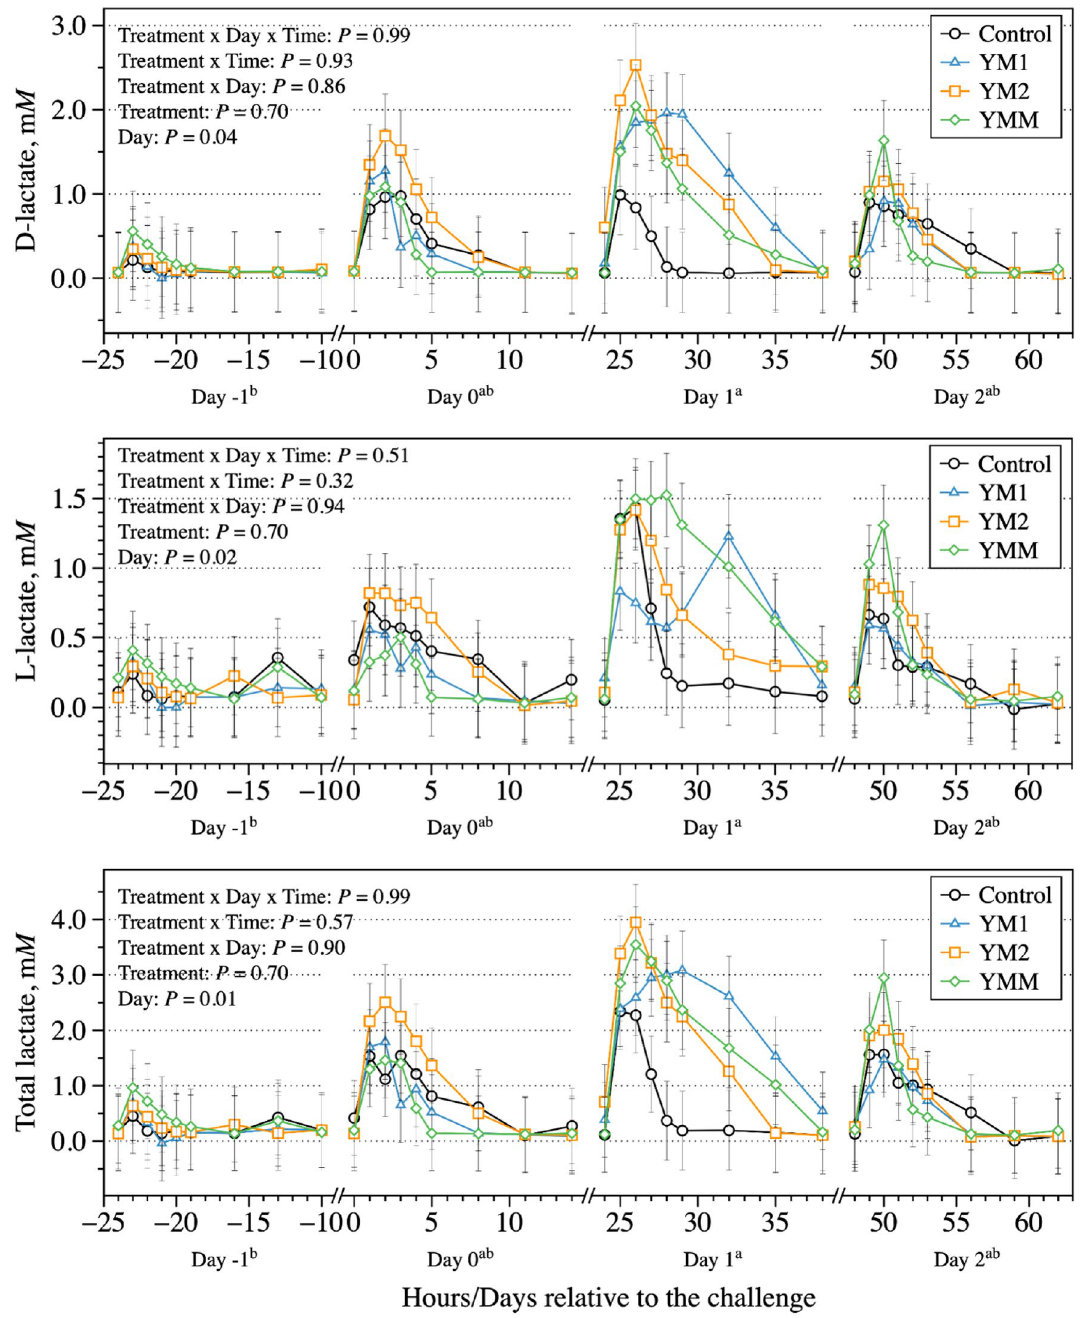
Figure 2. Dynamics of d-lactate, l-lactate, and total lactate concentration after the morning feeding on days 8, 9, 10, and 11 of each period to represents the days − 1, 0, 1, and 2 relative to the challenge; day 7 was used as a covariate to the model. All treatments had the same basal diet (1 mL of each DFM was applied per day at 1 × 10 8 cfu/mL); treatments were: Control, carrier of additives without DFM; YM1, S. cerevisiae and M. elsdenii strain 1; YM1, S. cerevisiae and M. elsdenii strain 2; YMM, S. cerevisiae and M. elsdenii strain 1 (1/2 dose) and strain 2 (1/2 dose). Statistical differences were declared at P ≤ 0.05 or as a trend to be different if P > 0.05 and <